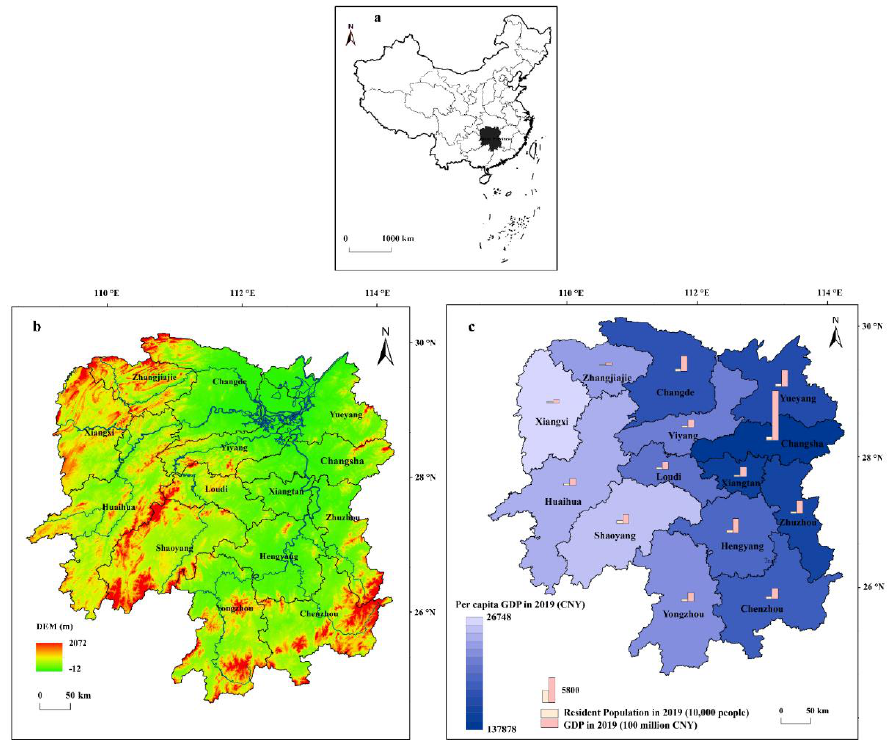
Figure 1. Location of Hunan Province highlighted in blue ( a ). Basic overview of the 14 prefecture- level cities in Hunan Province in terms of the environment, including main rivers and digital elevation model (DEM, m) ( b ), and society, including gross domestic product (GDP) and population ( c ).